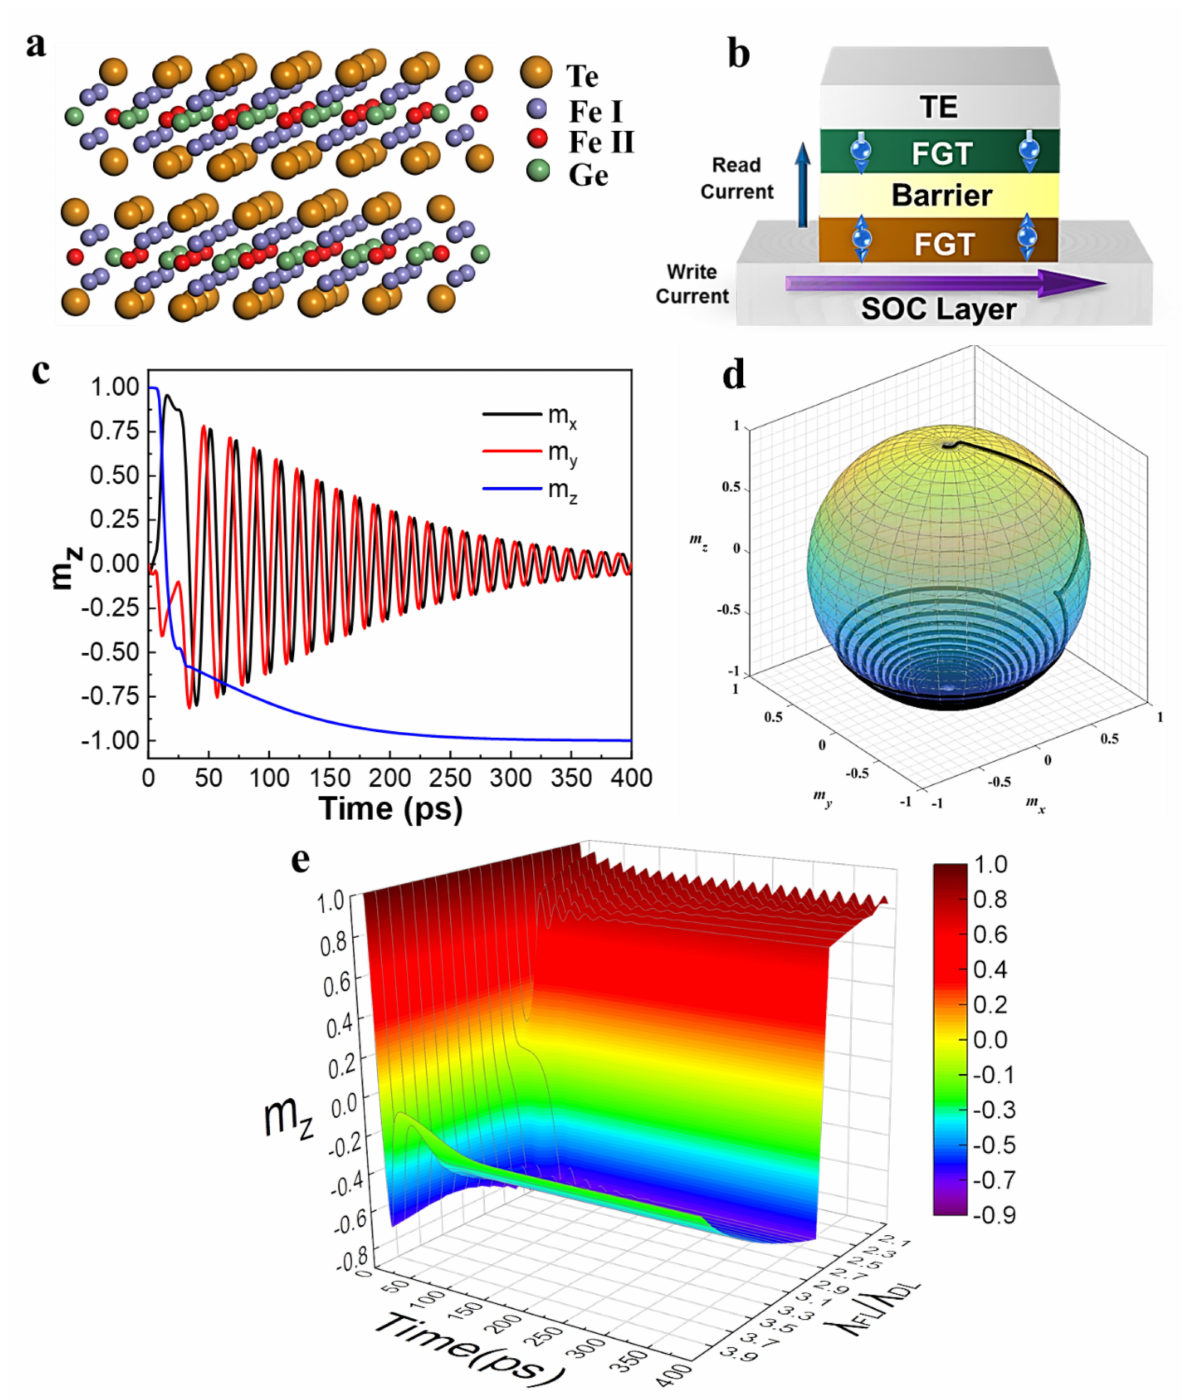
Figure 1. Proposed FGT-MTJ device: materials system, device structure, and magnetization switching dynamics. ( a ) The atomic crystal structure of FGT. ( b ) The basic FGT-MTJ structure. ( c ) Macro-spin simulation results of the time-dependent x-, y-, z-component magnetization (m x , m y , m z ) in the perpendicular FGT-MTJ under all-electrical control (pulsed current of J e = 7.9 × 10 7 A/cm 2 within 24 ps) without extra in-plane magnetic field. ( d ) Corresponding 3D m z precession dynamic trajectories after the pulse current are applied with an optimal ratio of λ FL / λ DL = 4. ( e ) The phase diagram of time dependent m z switching with different λ FL / λ DL ratios under J e = 7.9 × 10 7 A/cm 2